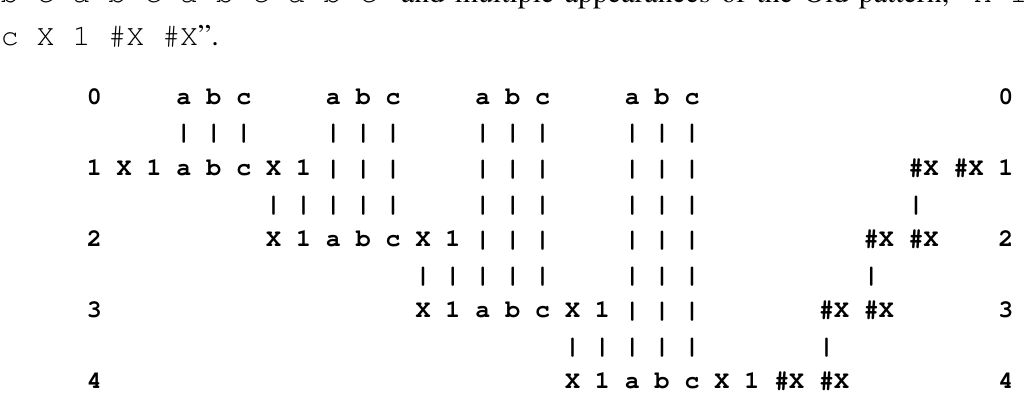
Figure 5. The best multiple alignment produced by the SP model with the New pattern “ a b c a b c a b c a b c ” and multiple appearances of the Old pattern, “ X 1 a b c X 1 #X #X